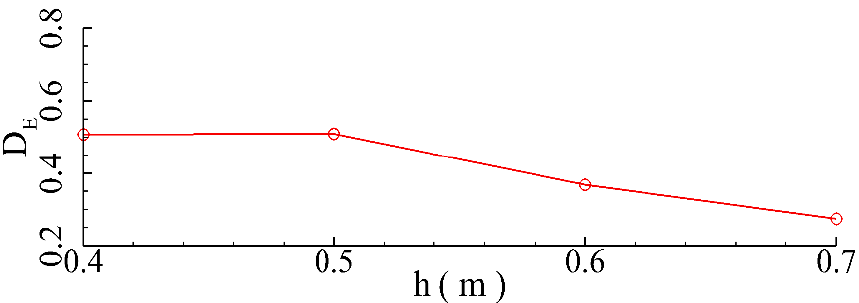
Figure 19. Dissipation rate of the wave energy under different water depths.